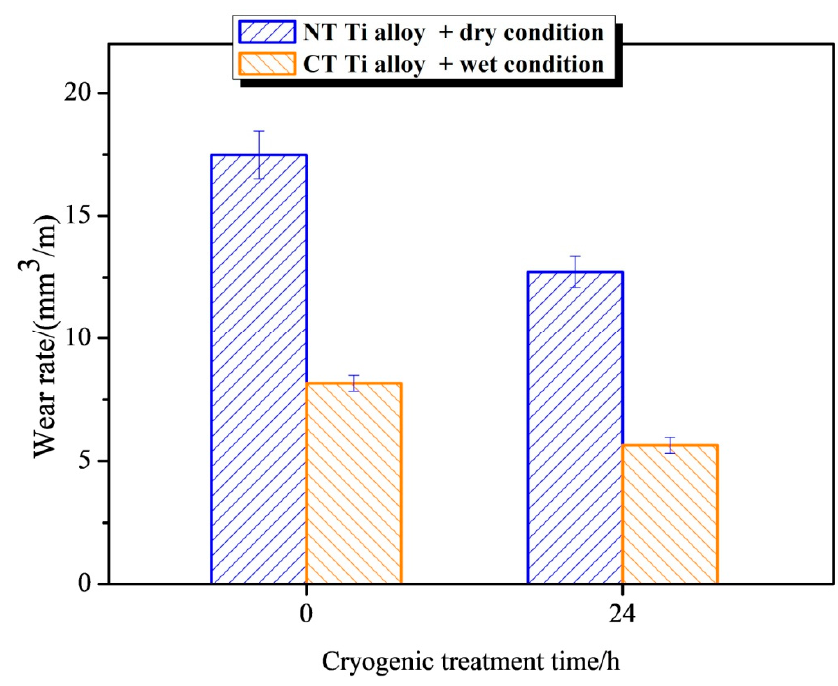
Figure 5. The wear rates of Ti-6Al-4V alloy with and without cryogenic treatment.